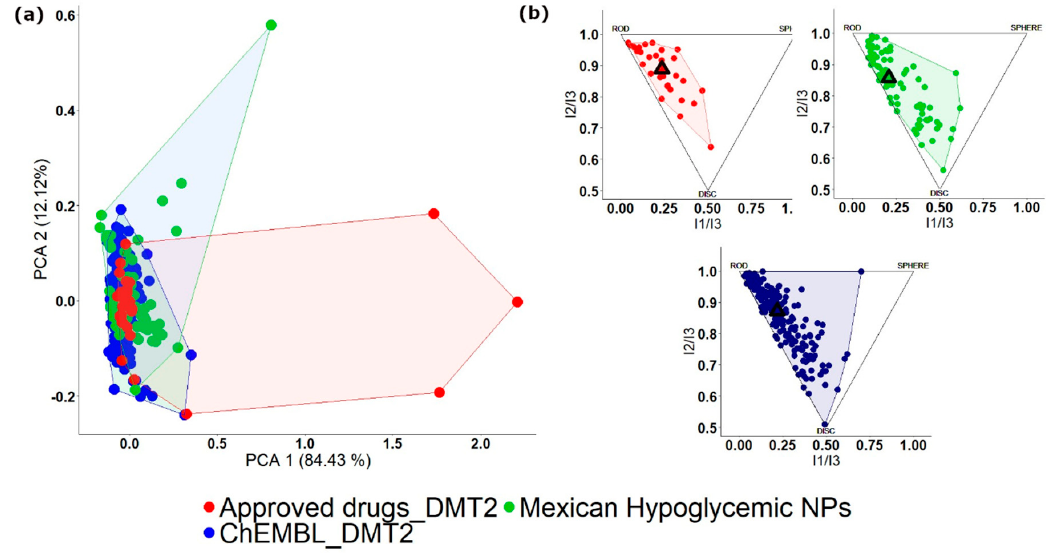
Figure 3. Visual representation of the chemical space of three different libraries: NPs isolated from Mexican hypoglycemic plants (green), drugs approved to treat DMT2 (red) and compounds from ChEMBL evaluated to treat DMT2 (blue) ( a ) Principal Component Analysis (PCA) plot generated using six structural and physicochemical descriptors (molecular weight, hydrogen bond donors, hydrogen bond acceptors, the octanol and/or water partition coefficient, topological polar surface area, and number of rotatable bonds); ( b ) Principal Moments of Inertia (PMI) plot. Compounds are placed in a triangle where the vertices represent rod, disc, and spherical compounds.